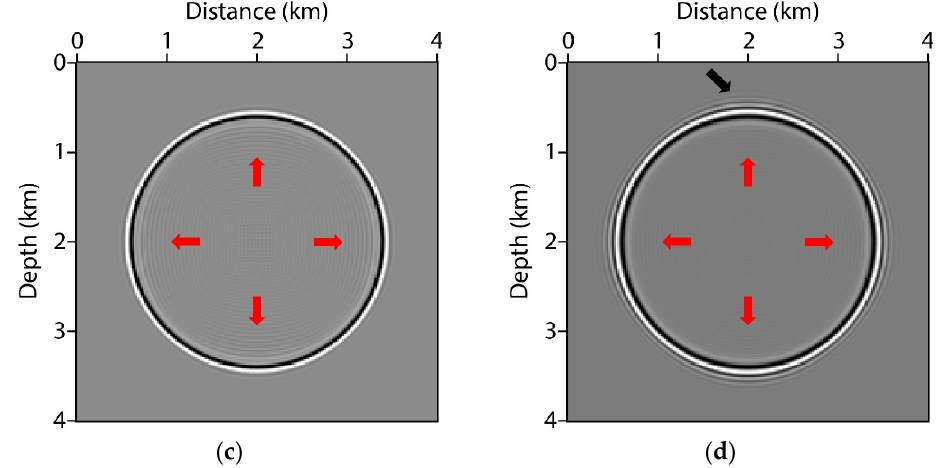
Figure A1. Snapshots of the homogeneous model at 0.5 s. They are simulated by: ( a ) CFD6 scheme, ( b ) OCFD6 scheme (0.5 π ), ( c ) OCFD6 scheme (0.75 π ), and ( d ) OCFD6 scheme ( π ), respectively. The red arrows indicate the spatial dispersion and the black arrow indicates the temporal dispersion.